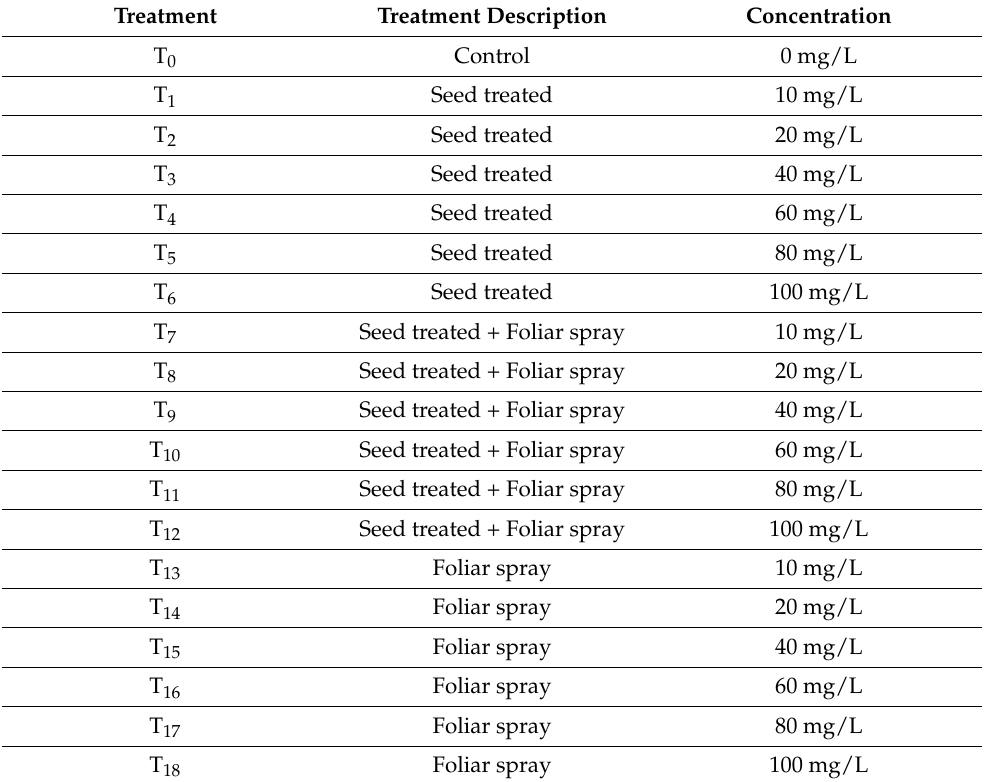
Table 1. Treatment layout of the